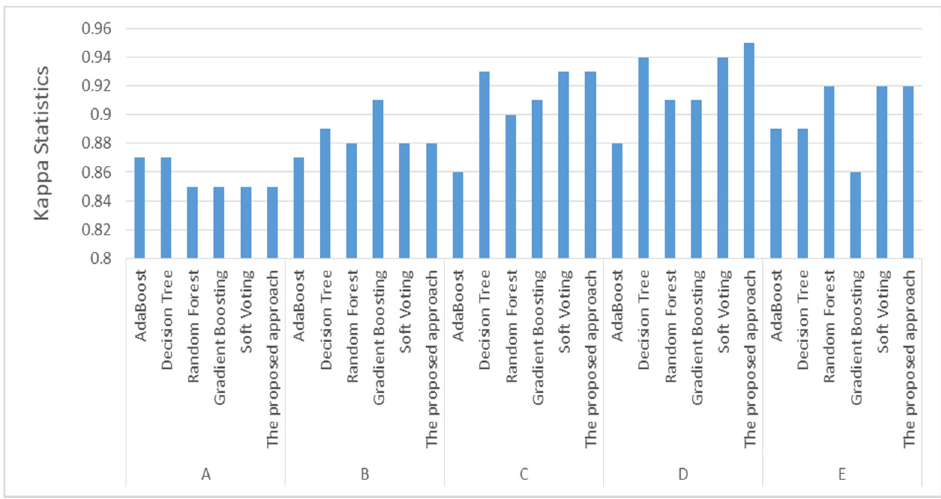
Figure 3. Kappa statistics for the proposed approach and other machine learning algorithms.